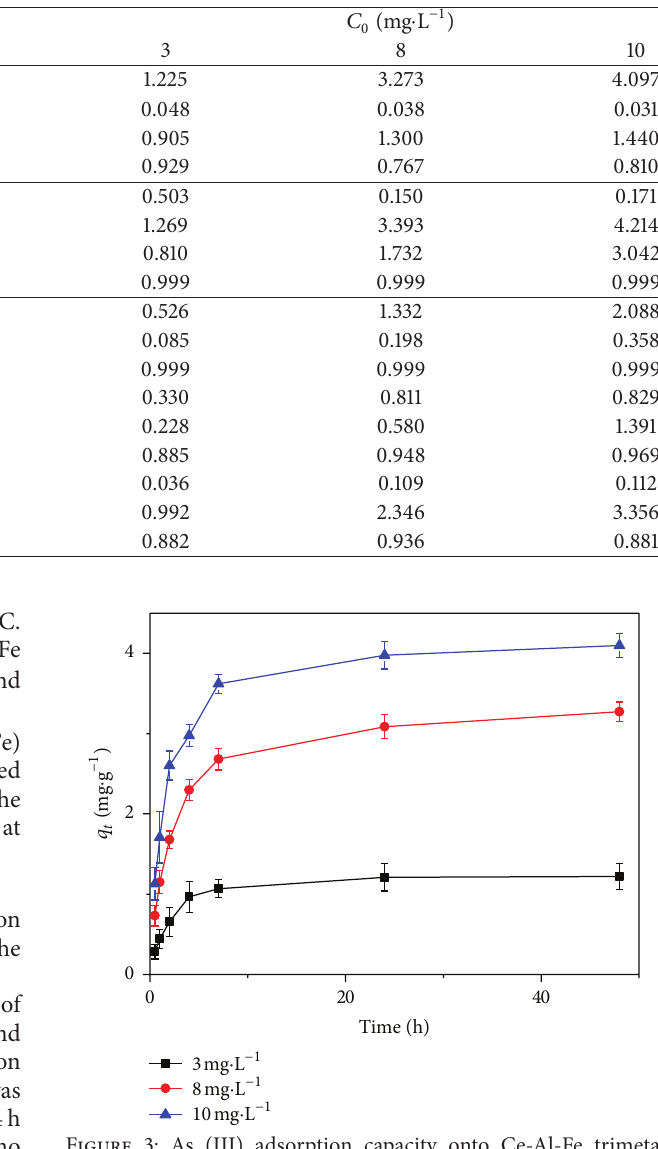
Table 1: The kinetic parameters for the pseudo-first-order, pseudo-second-order, and intraparticle diffusion model at different initial As (III) concentrations and 25 ∘ C.